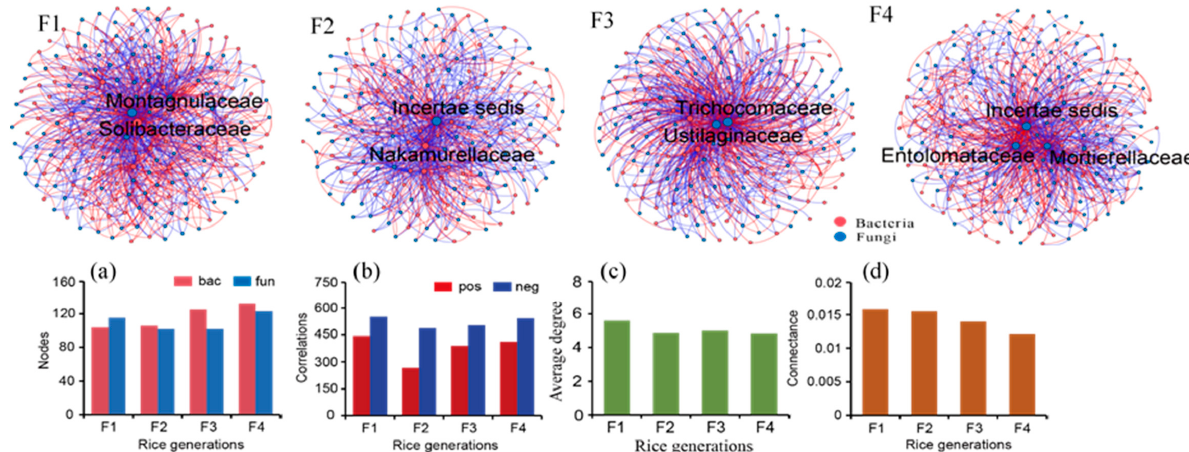
Figure 4. Network based on SparCC correlation coefficients (SparCC’s rho cut-off = 0.8, p < 0.01) showing the co-occurrence patterns of parental-affected groups of bacteria and fungi in different rice generations. Red and blue lines represent significant positive and negative ( p < 0.01) linear relationships, respectively. The rhizospheres of the hybrid generation ( F1 ) and the progenies obtained by self-crossing ( F2 , F3 , F4 ) were analyzed. Number of nodes ( a ), number of correlations ( b ), average degree ( c ) and connectance ( d ) of network for rhizosphere microbial communities for the rice progenies F1–F4.